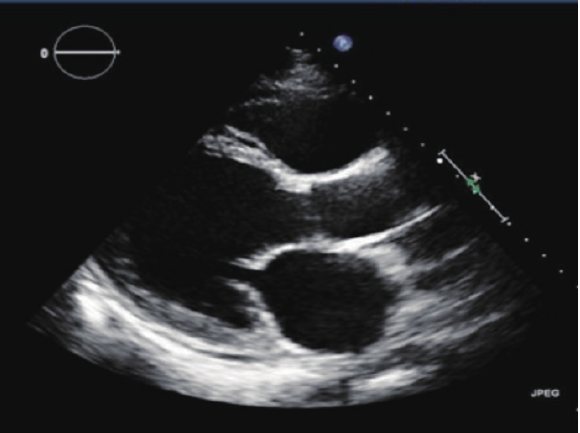
Figure 1 Left ventricular long-axis view: Left atrium and left ventricle are significantly enlarged, both ventricular septum and left ventricular posterior wall become thinner, and the opening of the mitral valve becomes smaller during diastole, forming a so-called "large cardiac chambers, small